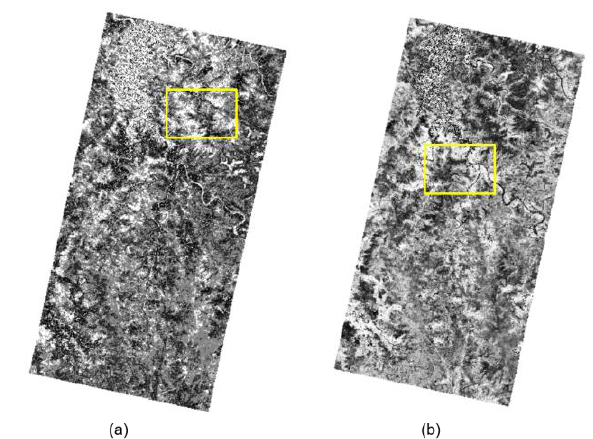
Figure 9. Narrowband Indices for PRISMA (Modified from ASTER band ratios) (a) Clay and Iron narrowband ratio (b) Amphibole narrowband